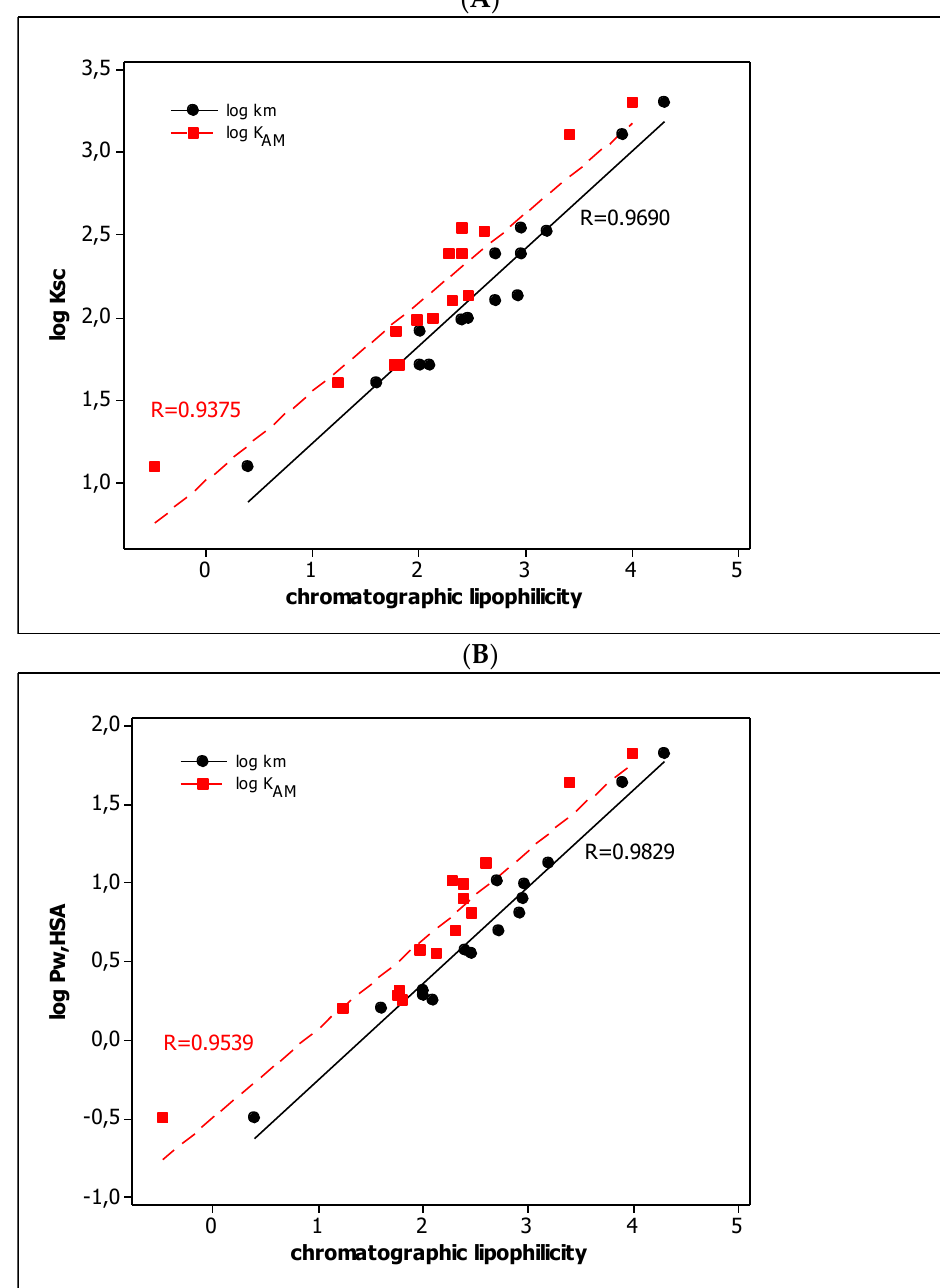
Figure 2. The linear relationships between log K sc ( A ) and log P w, HSA ( B ) and chromatographic parameters (log k m and log K AM ).